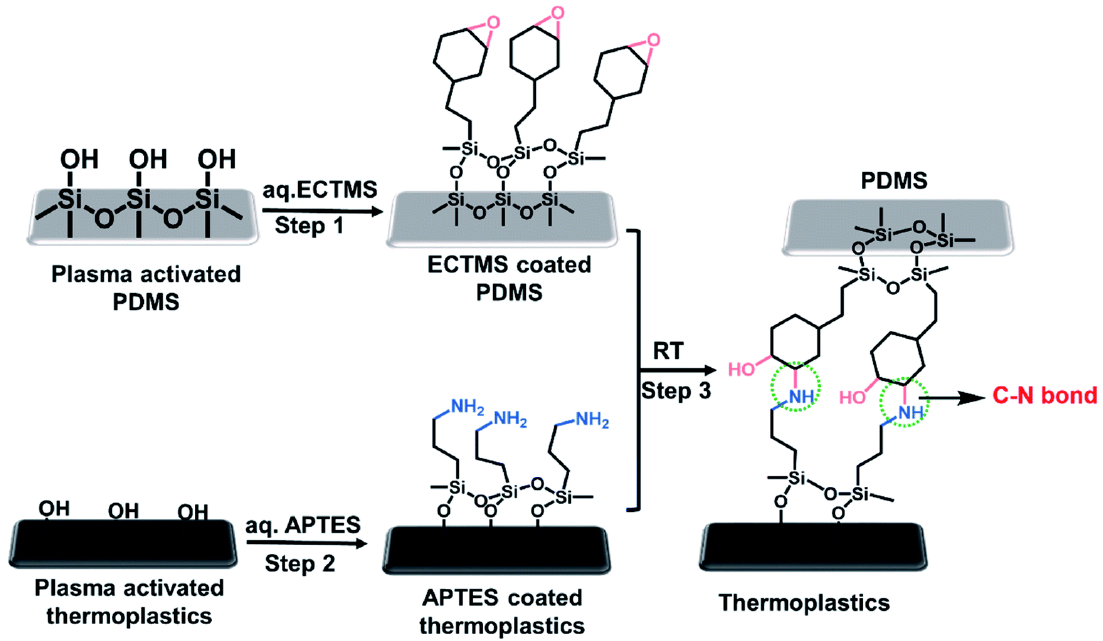
Figure 7. Schematic diagram of bonding of chemically treated PDMS – thermoplastic substrates [147]